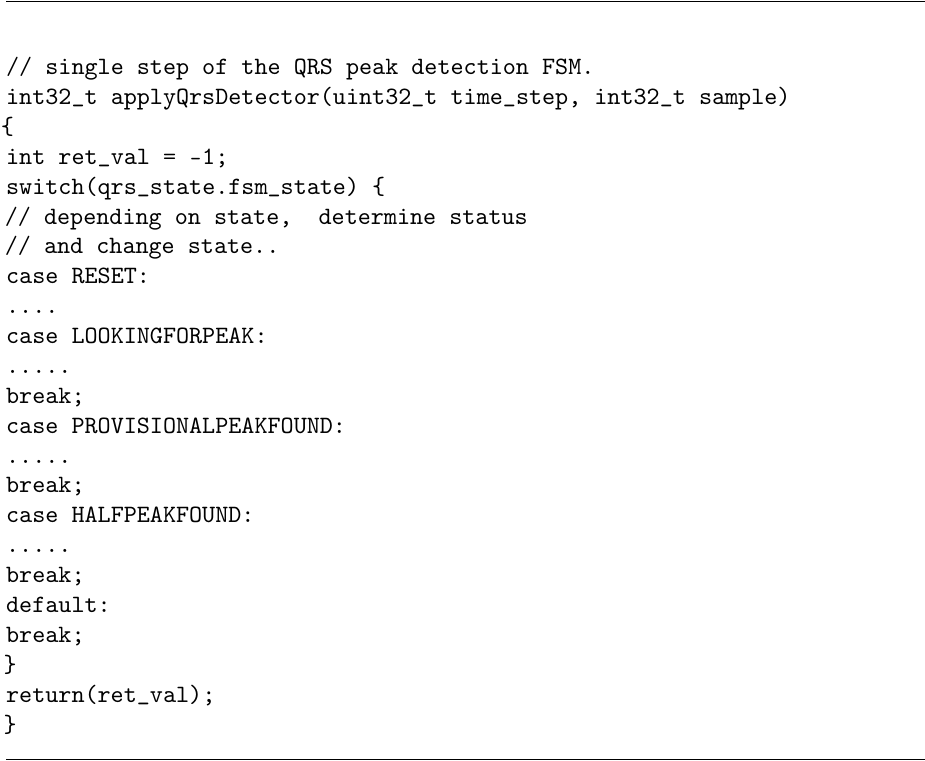
// single step of the QRS peak detection